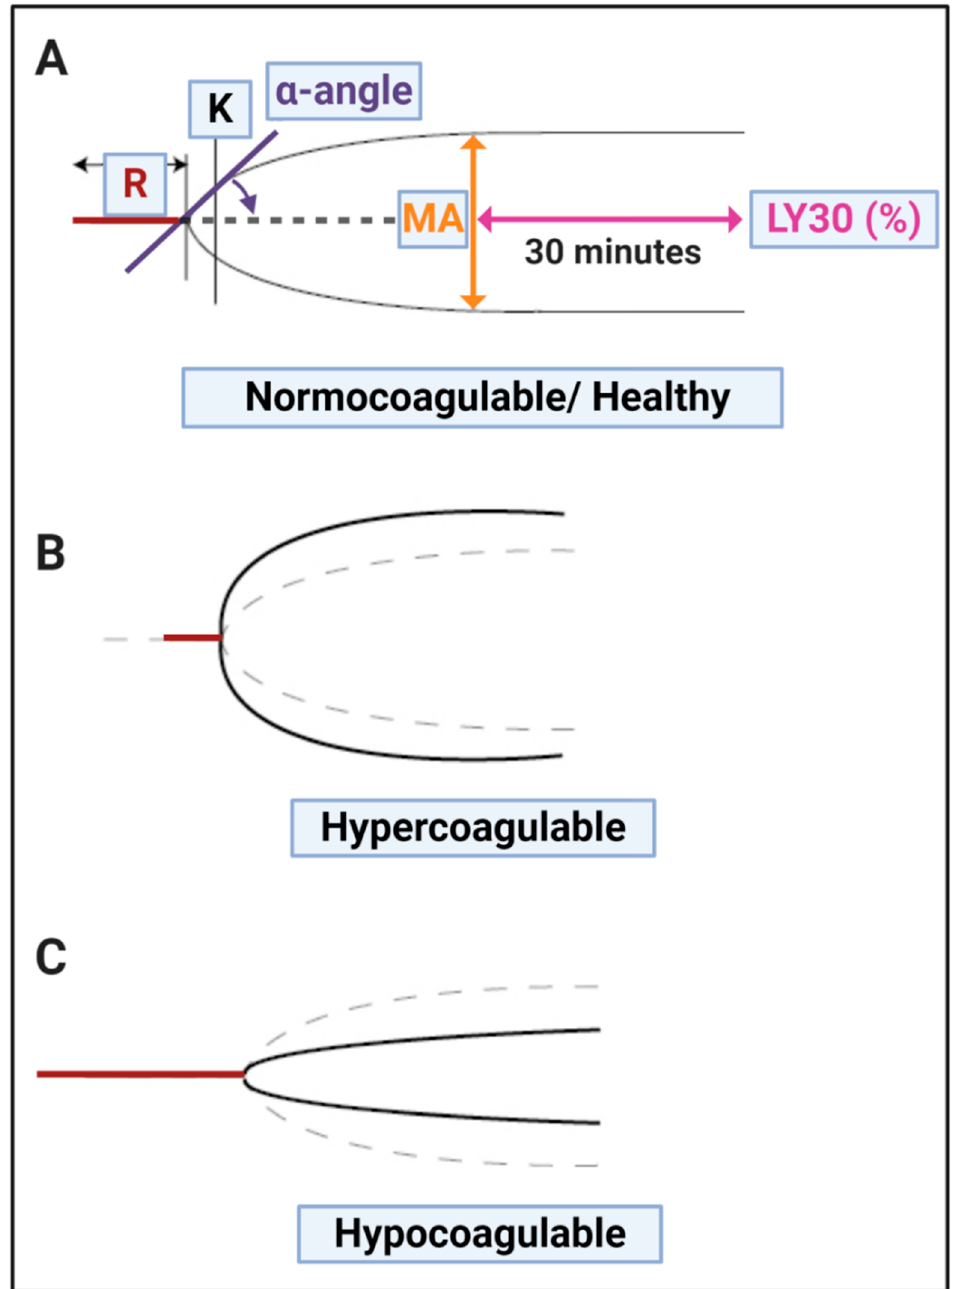
Figure 2. TEG ® traces with the various parameters discussed in Table 2, visualized. ( A ) Healthy (normocoagulable) trace; ( B ) Hypercoagulable trace and ( C ) Hypocoagulable trace. Image created with BioRender (https://biorender.com/ (accessed on 15 October 2021)).